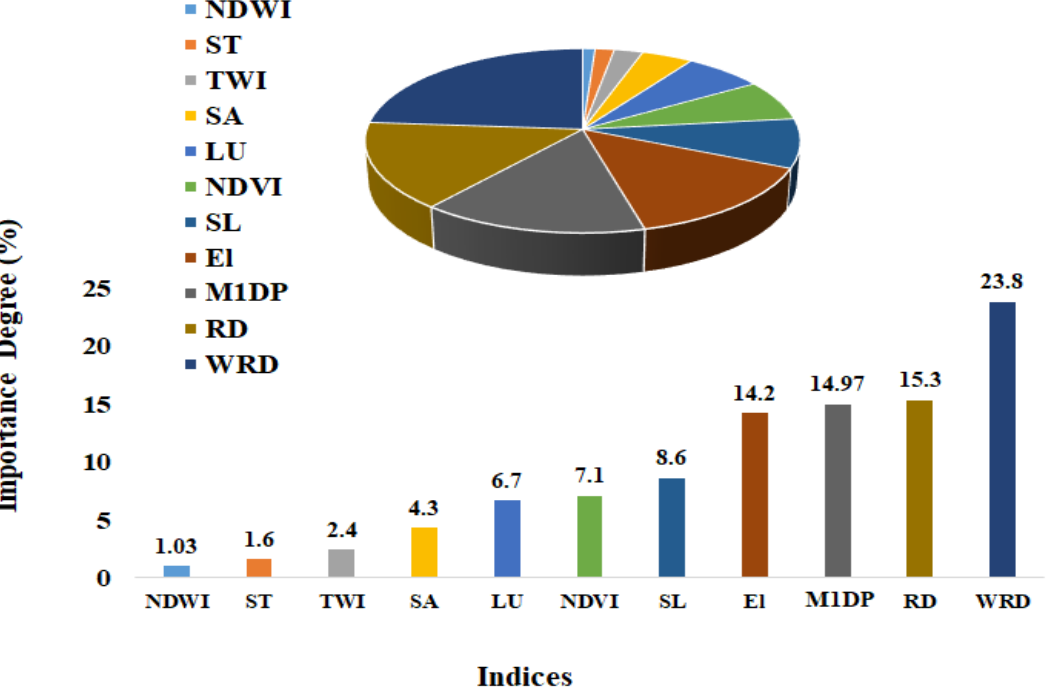
Figure 8. Relative importance degree of indices applied in the classification process.